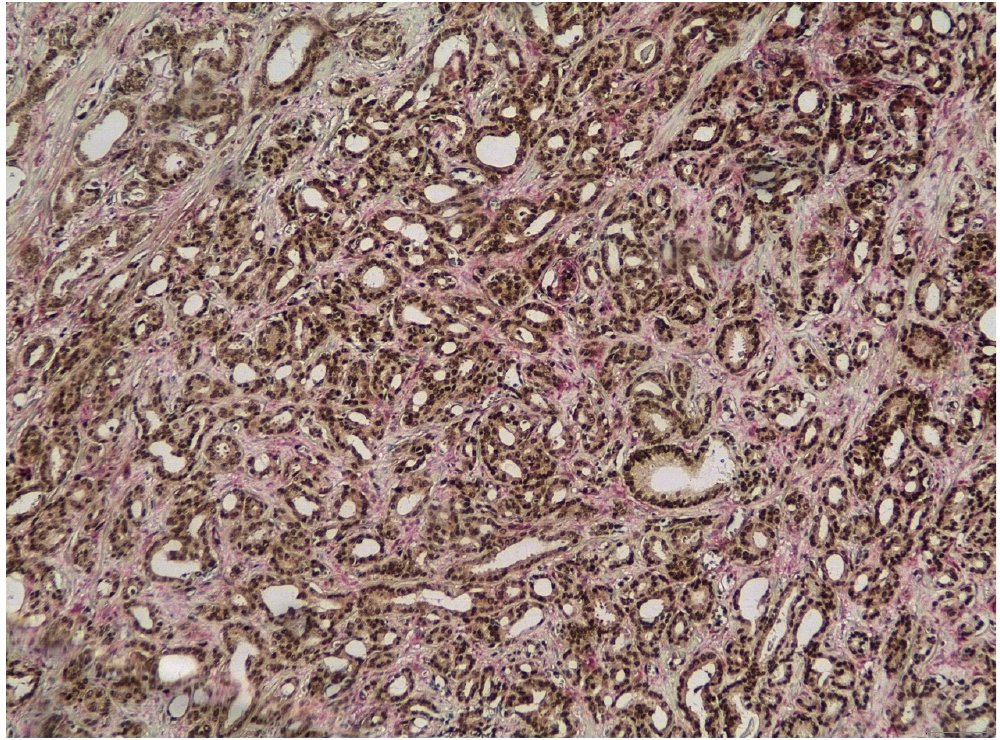
Figure 2. ERG nuclear immunopositivity combined with complete PTEN loss in cancerous tissue (×100).